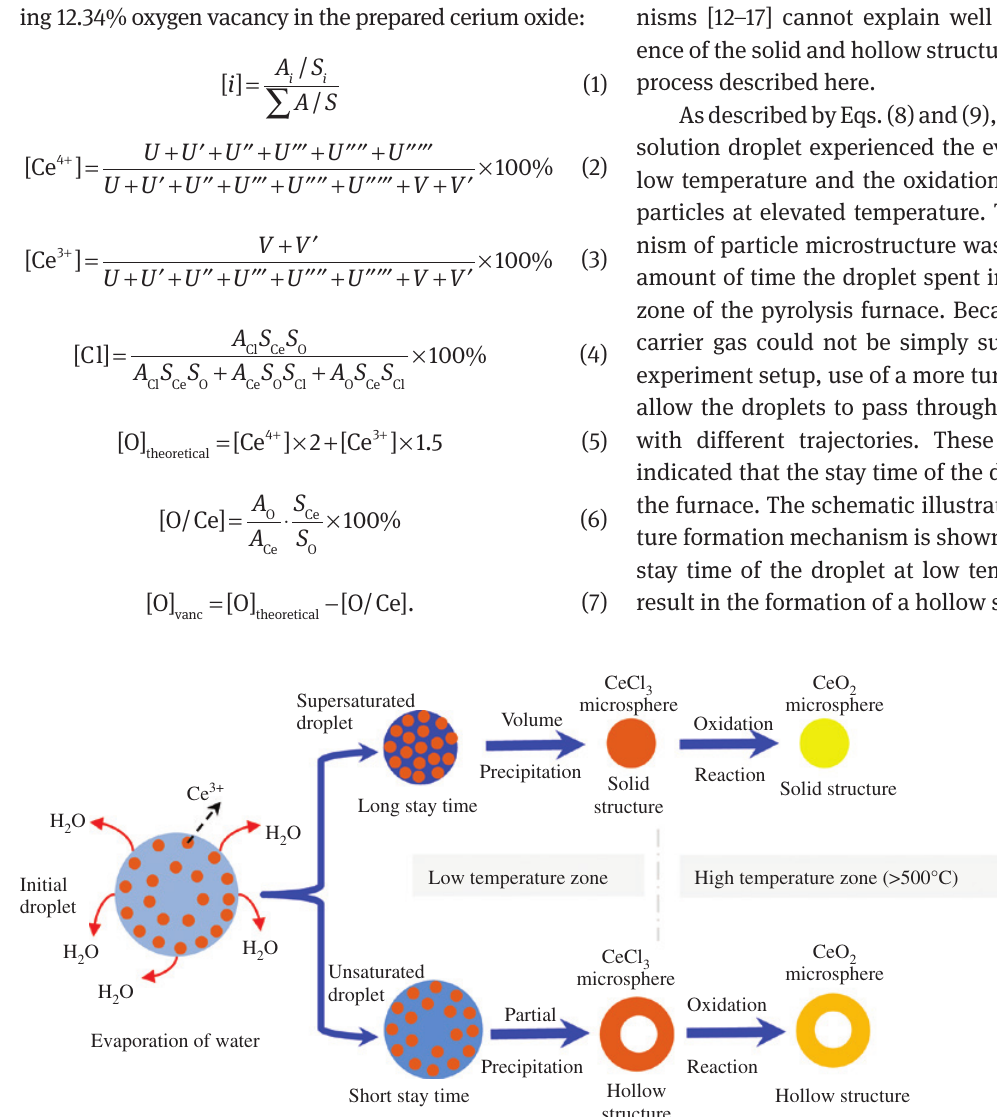
microsphere prepared by ultrasonic spray pyrolysis of CeCl 2